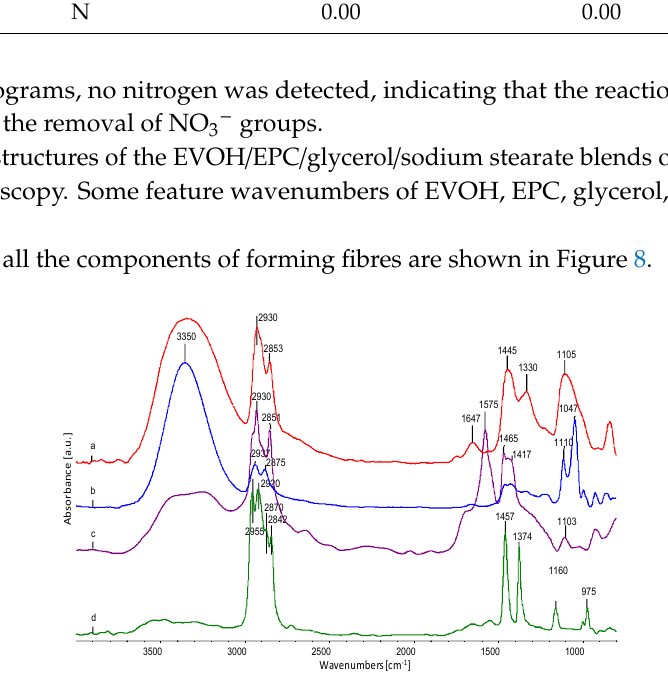
Figure 8. FTIR spectra of fibre forming components used; ( a ) EVOH, ( b ) glycerol, ( c ) sodium stearate, ( d ) EPC with the characteristic oscillation bands.